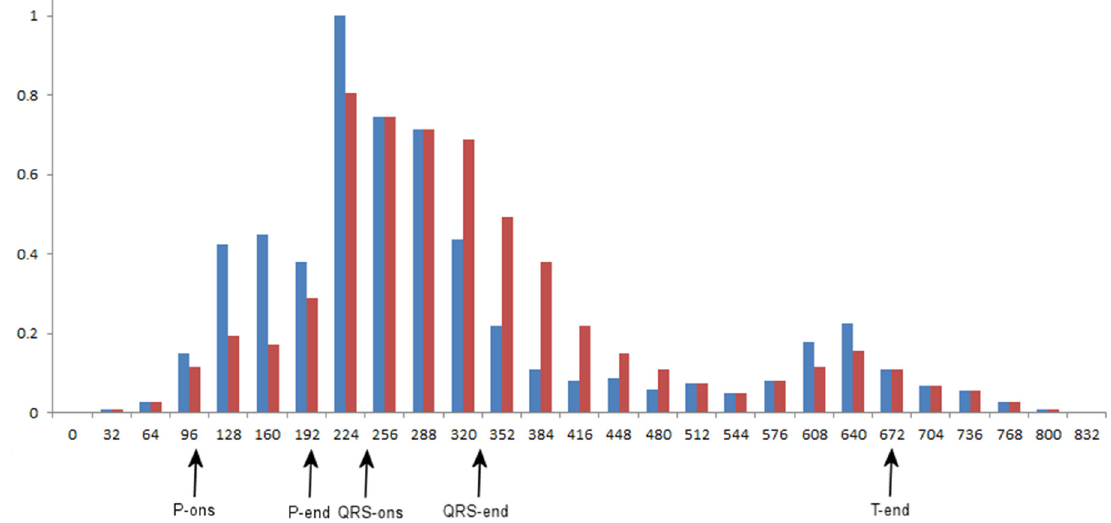
Figure 6. Comparison of bar graphs for scanpath-determined gMRF (blue) and example infarct or a conduction defect-oriented sMRF (red). Wave borders are: P-onset: 106, P-end: 196, QRS-onset 246, QRS-end: 338 and T-end 672.